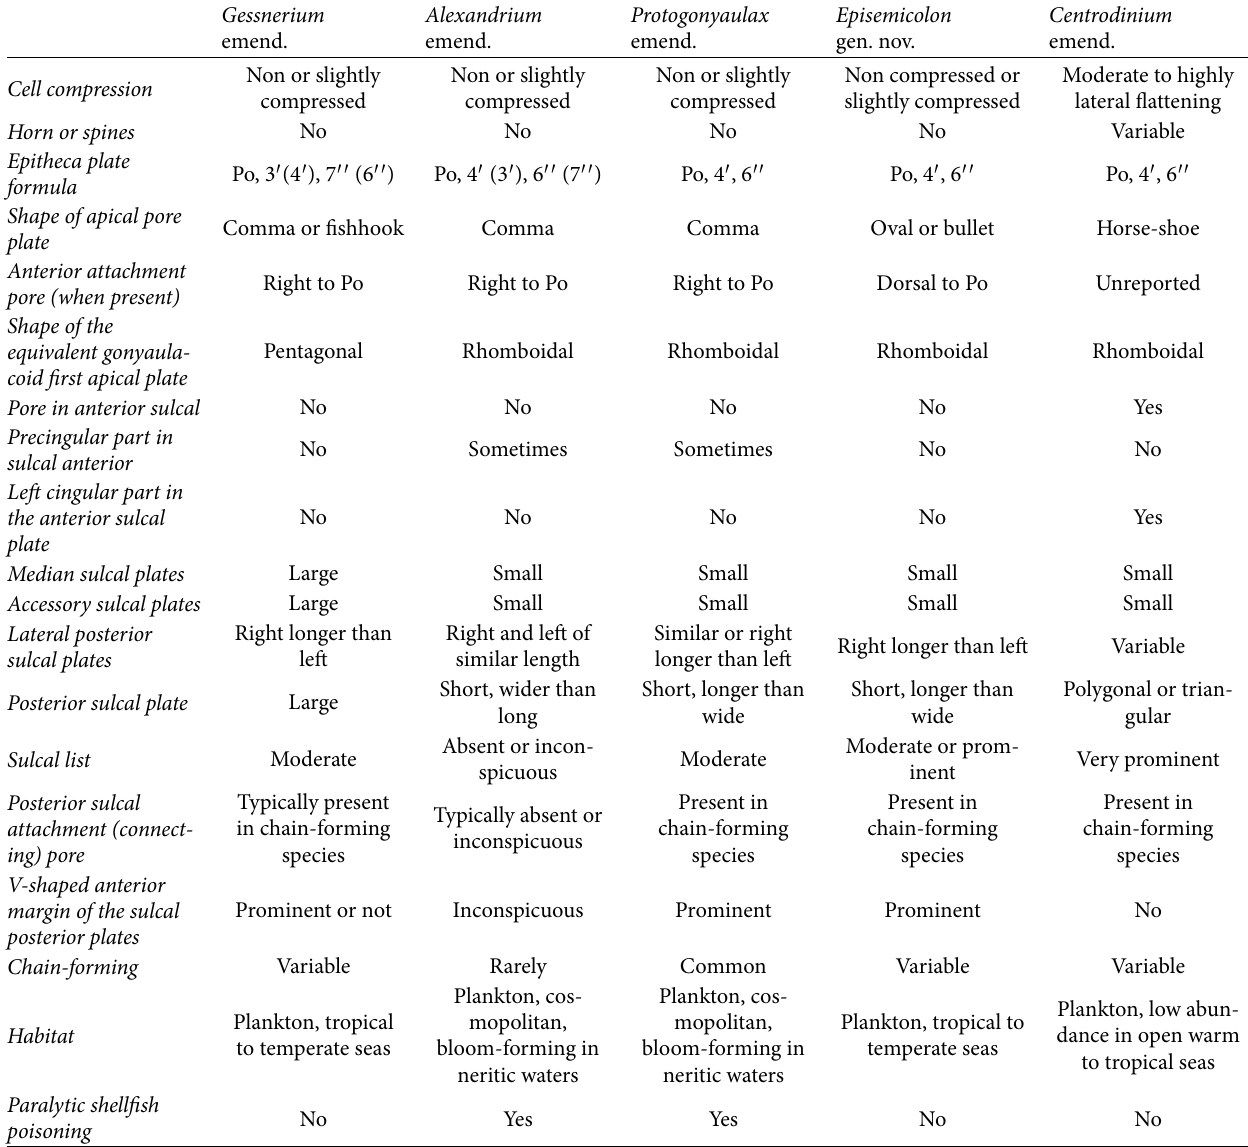
Table 1: Comparison of the morphological and ecological characters of the genera Gessnerium emend., Alexandrium emend., Protogon- yaulax emend., Episemicolon gen. nov., and Centrodinium emend. Gómez & Artigas. Data based on Balech (1995), and this